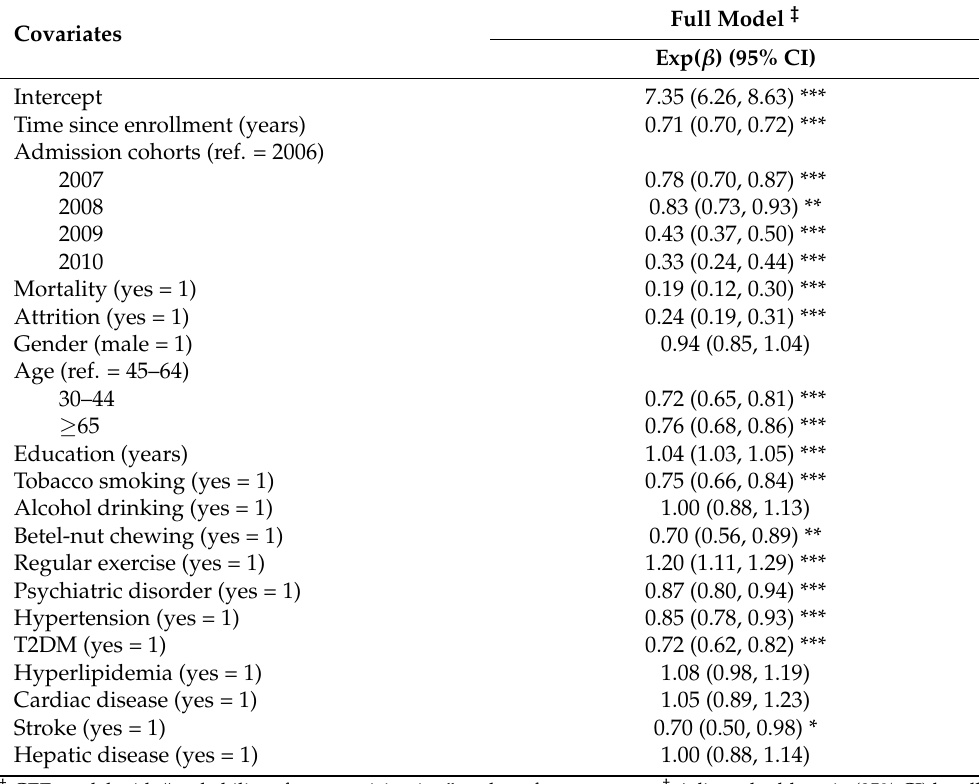
Table 3. GEE † logistic regression model of retention in the LIONS during 2006–2014.